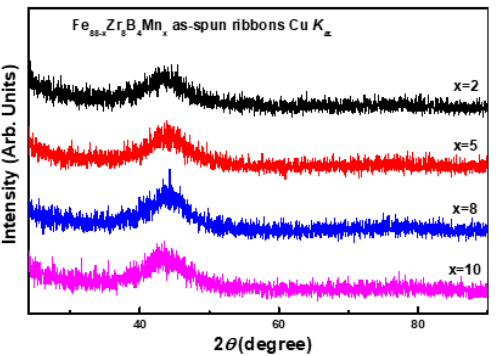
Figure 1. XRD patterns of the Fe 88 − x Zr 8 B 4 Mn x (x = 2, 5, 8, 10) as-spun ribbons.